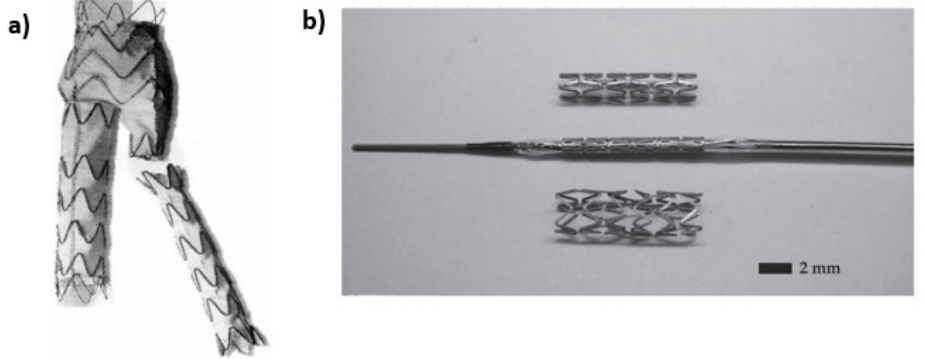
Figure 2. Top image: Photographs of a patient with erythema and rash after implantation of a stainless steel bar. Bottom image: typical symptoms reported in patients implanted with steel bars as part of a Nuss procedure for repair of pectus excavatum. Patients did not have a history of metal allergy prior to implantation. Reproduced with permission from [52].